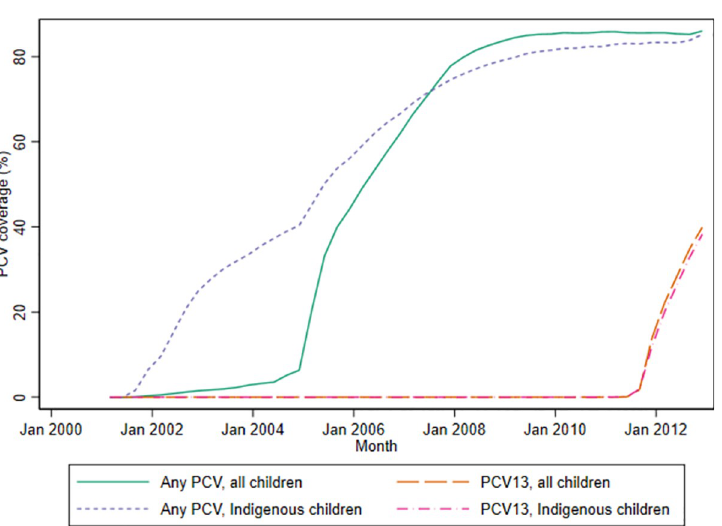
Fig 1. Quarterly coverage � of any PCV and PCV13 among children under 5 years of age, New South Wales and Western Australia, 2001–2012. � Vaccinated defined as 2 or more PCV doses administered at < 12 months of age or at least 1 PCV dose administered after the age of 12 months. PCV AU : AbbreviationlistshavebeencompiledforthoseusedinFigs 1 (cid:0) 6 : Pleaseverifythatallentriesarecorrect : , pneumococcal conjugate vaccine; PCV13, 13-valent PCV; WA, Western Australia.